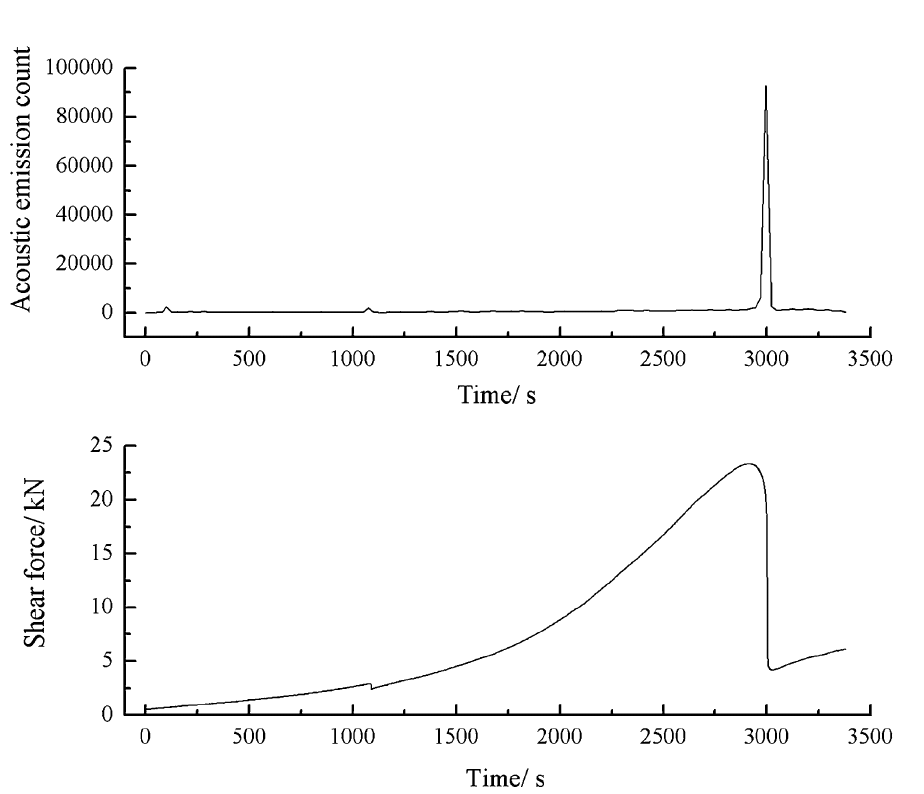
Figure 57. Shear stress–time and count-time curves for a specimen containing 0–2.56 mm sand particles (produced from three grain size